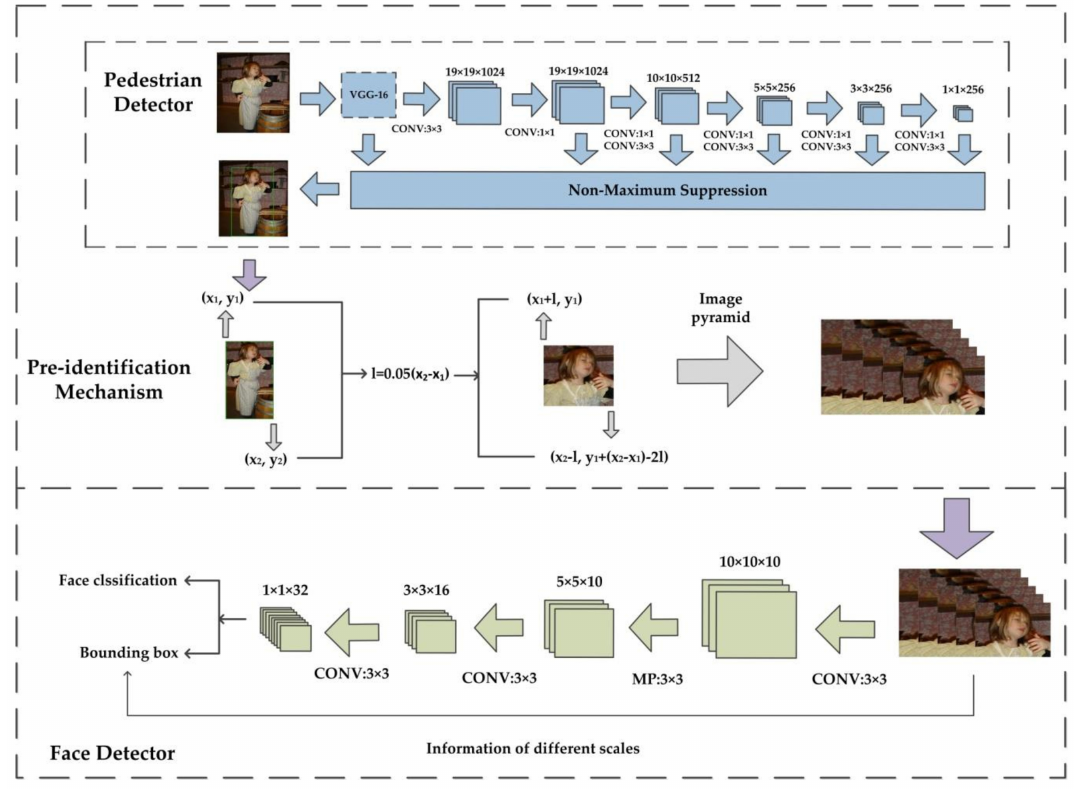
Figure 1. The whole